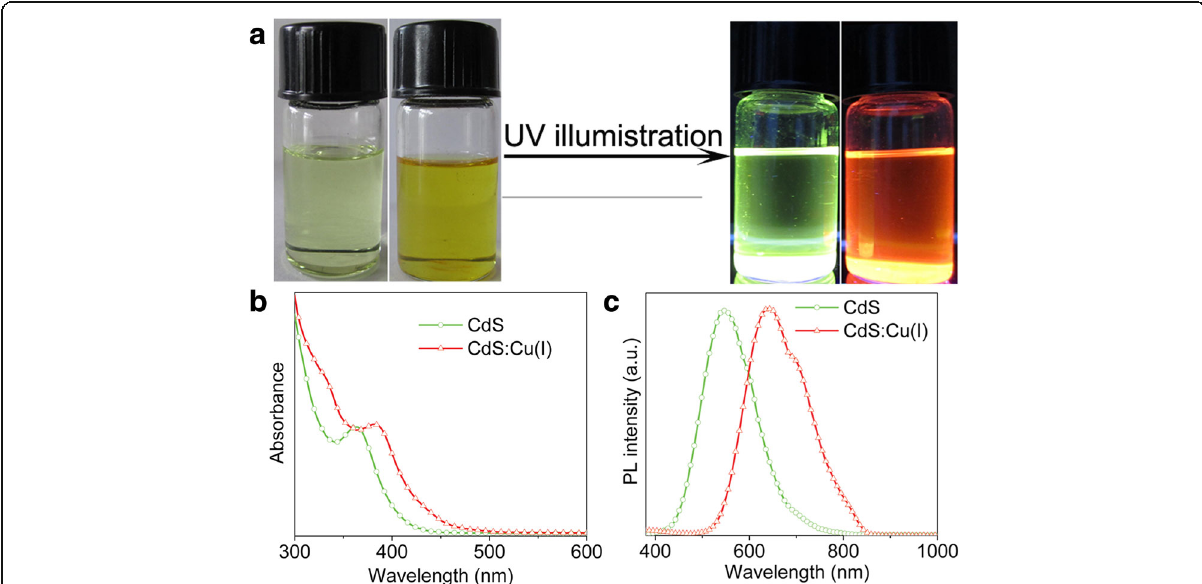
Fig. 7 a Digital pictures of CdS and CdS:Cu(I) nanocrystals solution in chloroform before (left) and after (right) irradiation under a 365nm UV lamp. b UV-Vis. c Fluorescence emission spectra of CdS and CdS:Cu(I) NCs, and the excitation wavelength is 350nm